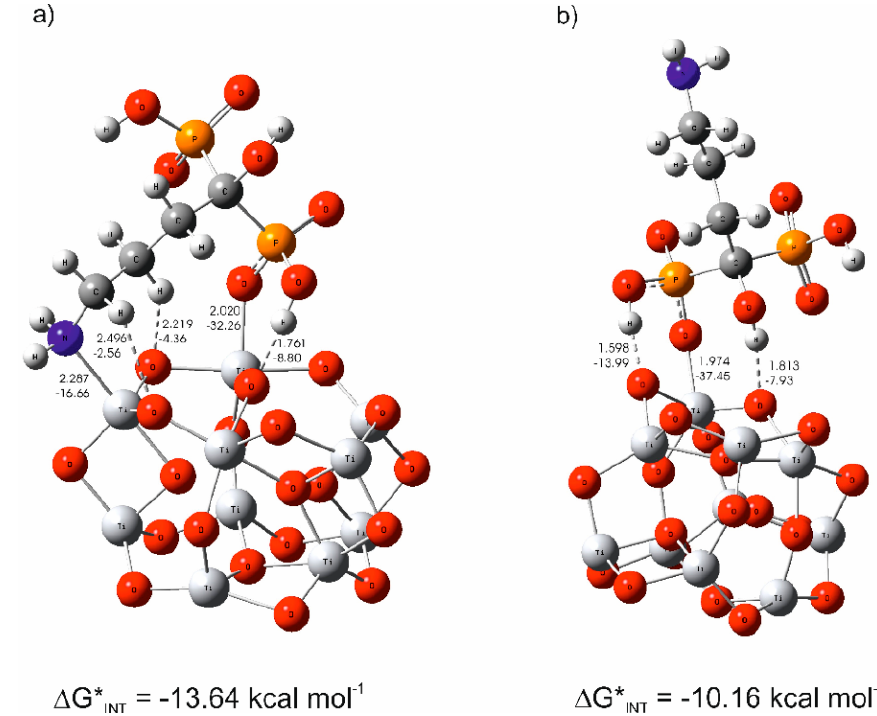
Figure 4. ( a ) The most stable structure and ( b ) less stable structure of the (TiO 2 ) 10 – alendronate, predicted by density functional theory (DFT), with calculated bond distances in Å and bond energies in kcal mol − 1 .